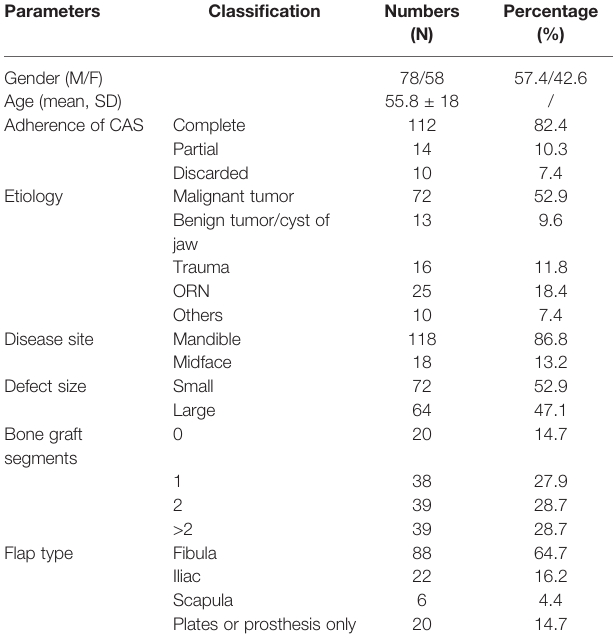
TABLE 1 | Patients